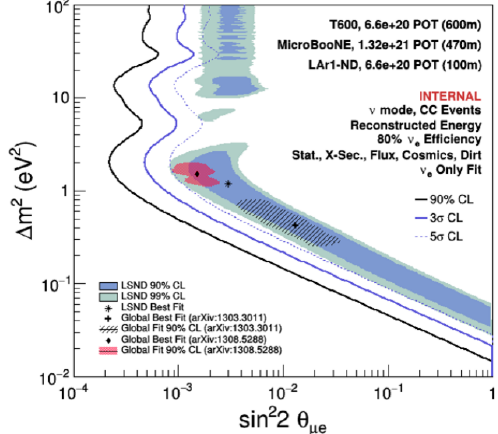
Figure 12. Sensitivity of the SBN Program to ν µ → ν e oscillation